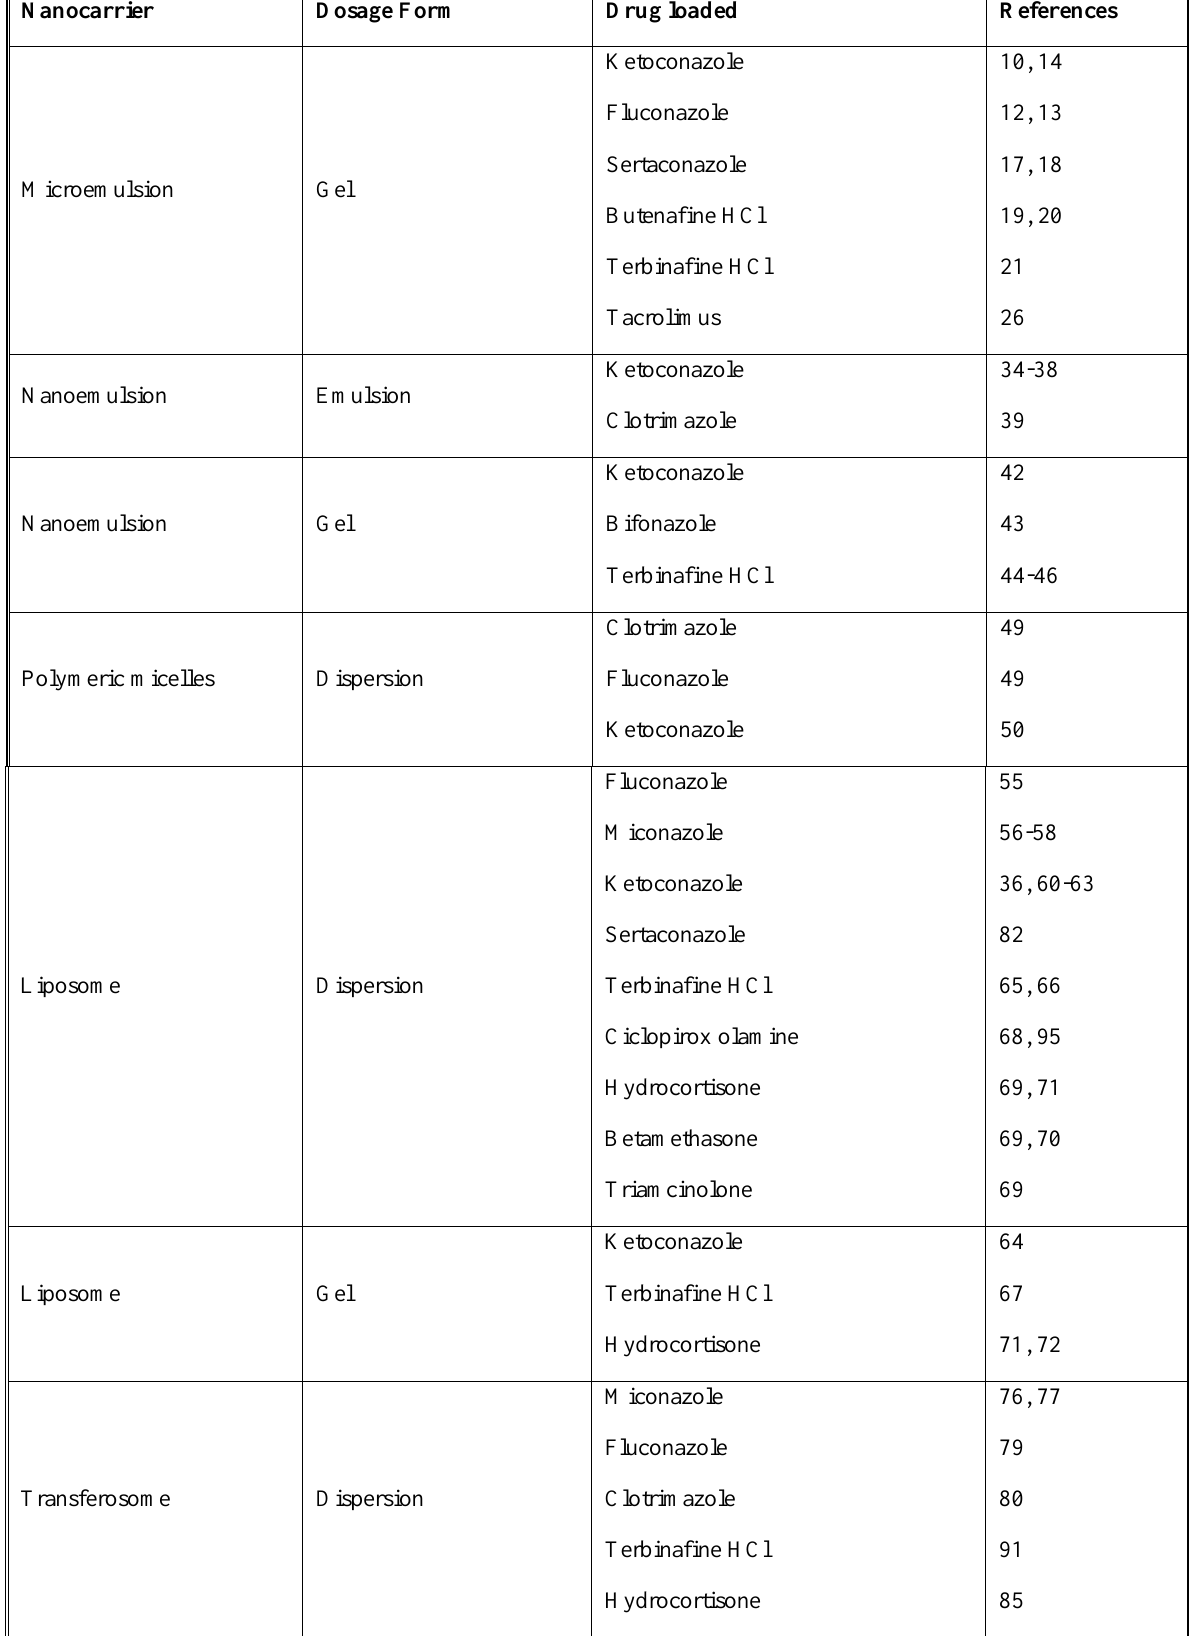
Continue Table 2. Summary of the most common nanocarriers for skin delivery of drugs used in